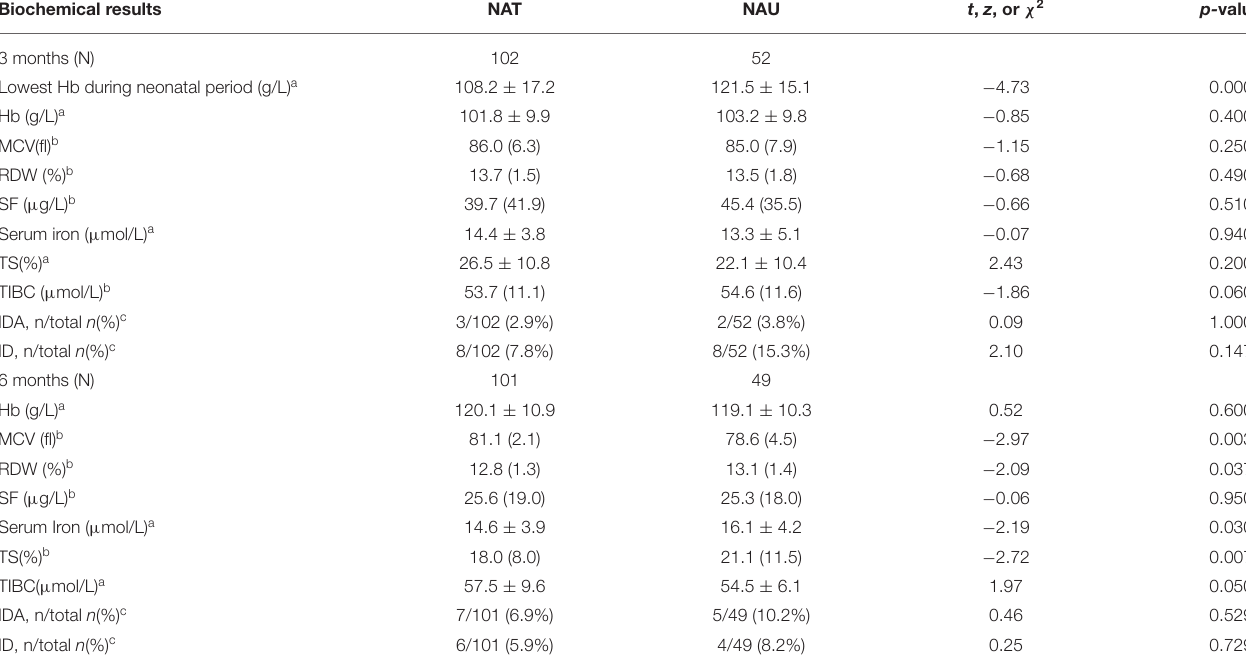
TABLE 3 | Comparison of iron status between NAT and NAU group at 3 and 6 months. Biochemical